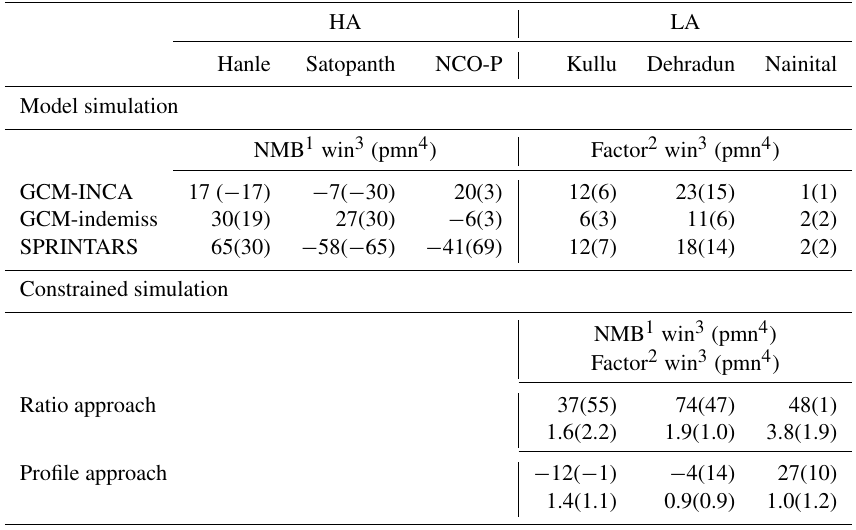
Table 4. Comparison of model output range of atmospheric BC concentration with the observed values at different